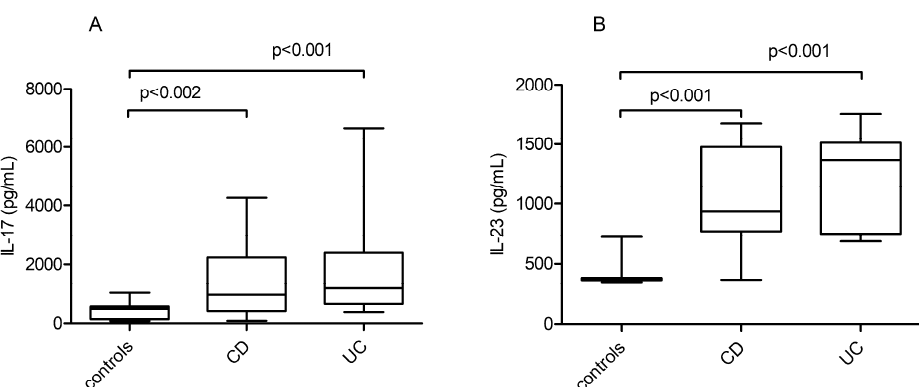
Figure 2. IL-17 and IL-23 quantitative serum level distribution in IBD patients and the control group: ( A ) IL-17 serum levels in UC patients, CD patients, and the control group. ( B ) IL-23 serum levels in UC patients, CD patients, and the control group.